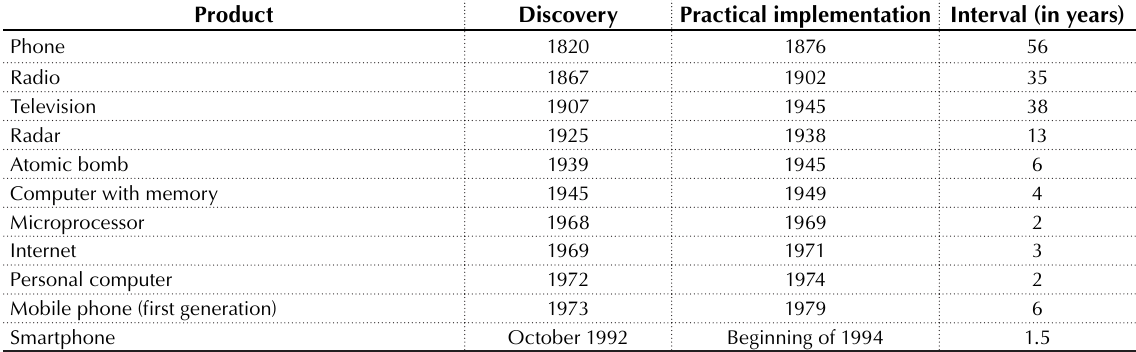
Source: Sedlyar (2012, p.